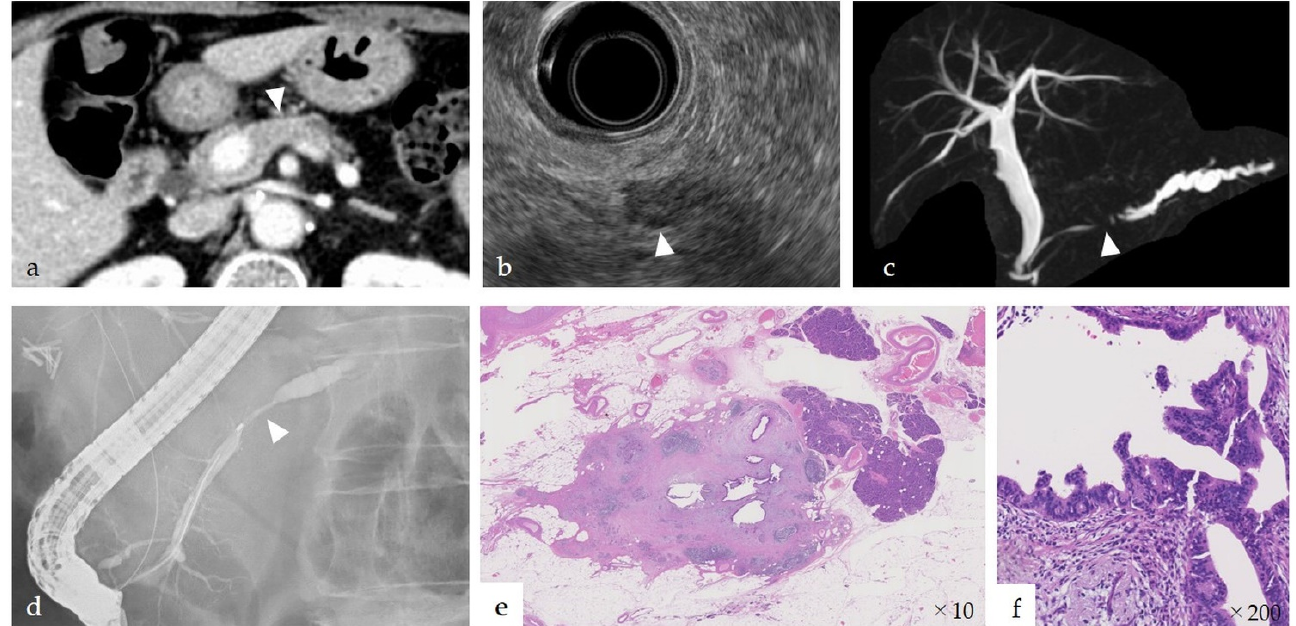
Figure 2. An 82-year-old woman with pancreatic carcinoma in situ (PCIS). ( a ) Localized tissue atrophy was observed in the pancreatic body on computed tomography (arrowhead). ( b ) Endoscopic ultrasonography (EUS) revealed a hypoechoic area, indicating a mass (arrowhead). ( c ) Magnetic resonance cholangiopancreatography revealed that the main pancreatic duct (MPD) was stenotic (arrowhead) in the pancreatic body and the dilated in the caudal part. ( d ) Endoscopic retrograde cholangiography revealed that the MPD was stenotic in the pancreatic body (arrowhead) and dilated in the caudal part. ( e , f ) Histopathological findings revealed PCIS in the stenosis of MPD, inflammation and fibrosis surrounding the PCIS, and changes in the fatty tissue in localized regions of the pancreatic parenchyma. This fibrosis corresponded to the hypoechoic area observed using EUS.